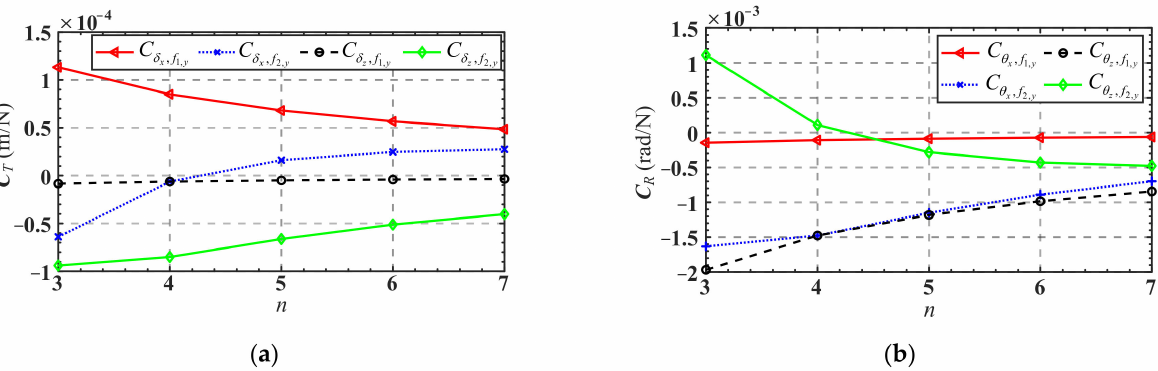
Figure 17. ( a ) Variation of mapping matrix C T in terms of branches number n ; ( b ) variation of mapping matrix C R in terms of branches number n